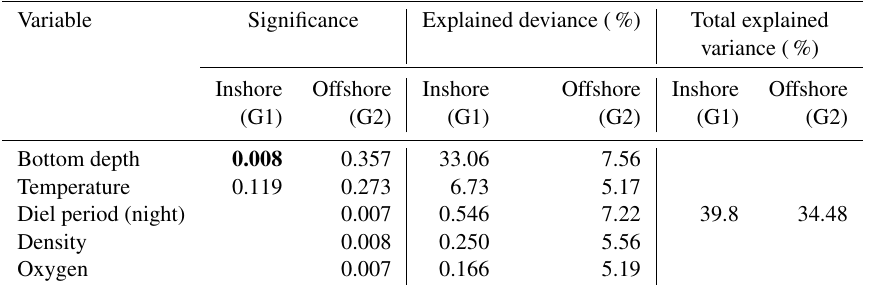
Table 3. Result of ANCOVA models between sound-scattering-layer (SSL) density (log( s A ) ) and environmental parameters (temperature, density, dissolved oxygen, chlorophyll a , diel period, and bottom depth) in the inshore area (G1) and the offshore area (G2). G1: multiple R 2 is 0.398, adjusted R 2 is 0.3178, and p value is 0.022; G2: multiple R 2 is 0.3448, adjusted R 2 is − 0 . 01258, and p value is 0.490; significant p values in